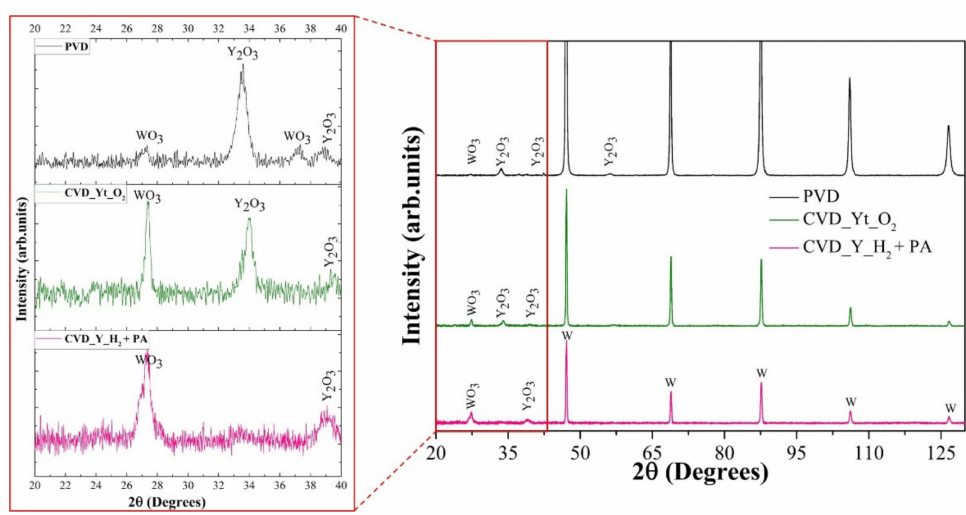
Figure 5. XRD diffractograms of CVD- and PVD-coated WO 3 /Y 2 O 3 /W f ( right ); the 2 θ region from 20 ◦ to 40 ◦ is plotted as a separate zoomed-in plot ( left ) to elucidate the diffraction peaks originating from the